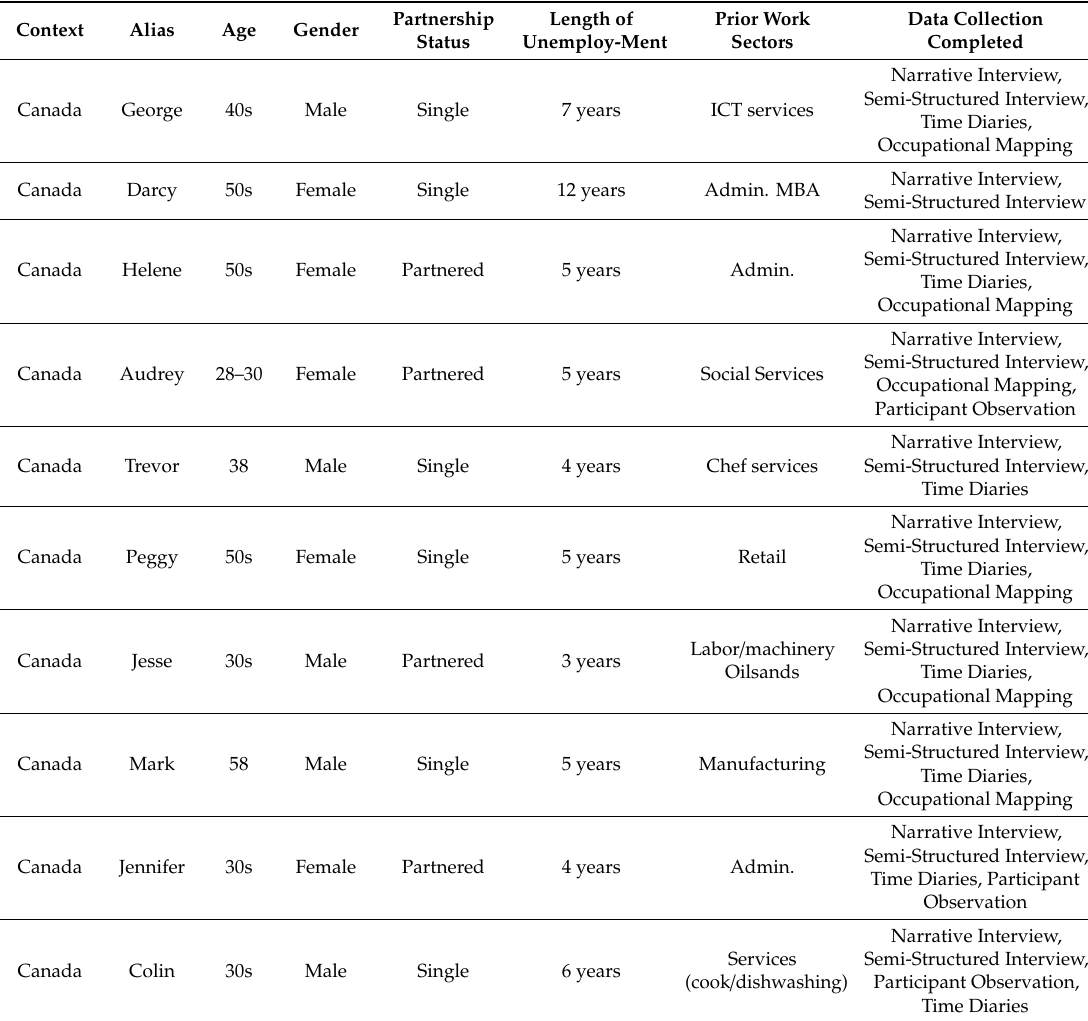
Table 2. Phase III participant